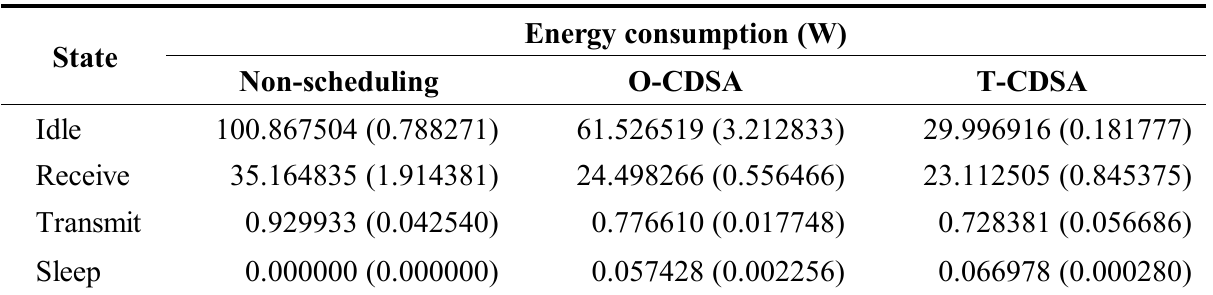
Table 4. Energy consumption in each state.